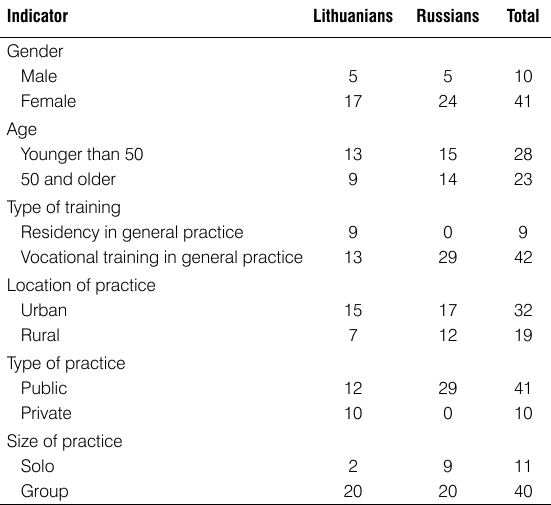
Table 1. Demographic breakdown of GP